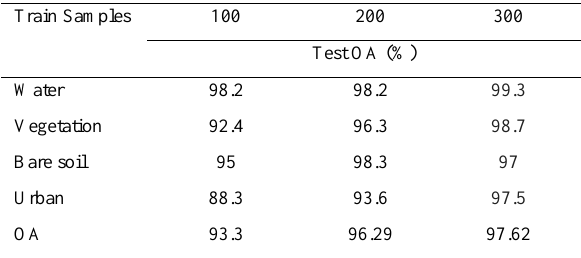
Table 6. Classification results of the second dataset for the proposed 2-D convolutional network